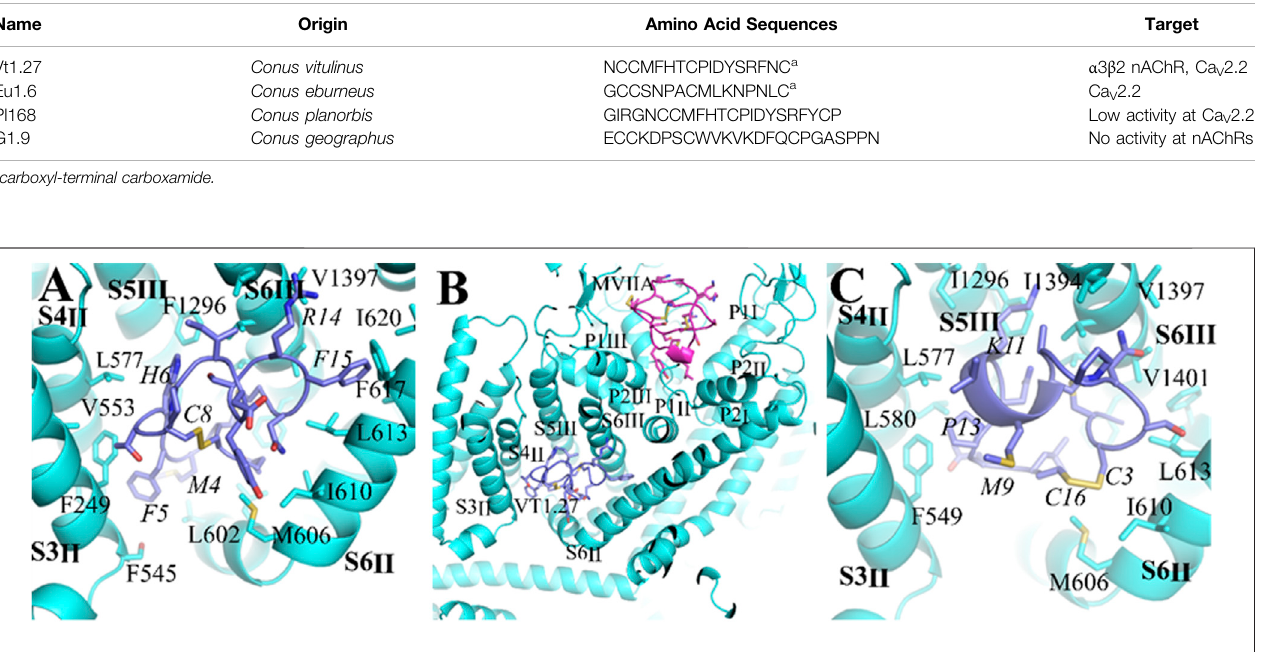
FIGURE8| Comparison ofbindingmodesoftheCa V 2.2channelwithVt1.27,MVIIAandEu1.6. (A)(C) Theinteraction of α -conopetidesVt1.27(purple)andEu1.6 (purple), (B) General view of the interaction sites of Vt1.27 and a pore-blocker ω -conotoxin MVIIA (pink). The Ca V 2.2 channel is shown in blue, the residues from Vt1.27 and Eu1.6 are labeled in italic